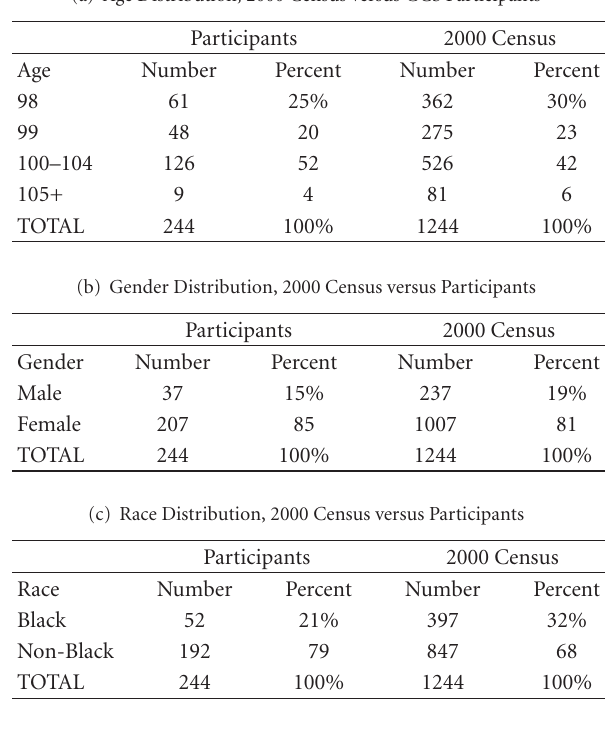
Table 1: Demographics of 2000 Census in Georgia and GCS study participants. In (b) and (c) entries for Participants and 2000 Census are for centenarians and